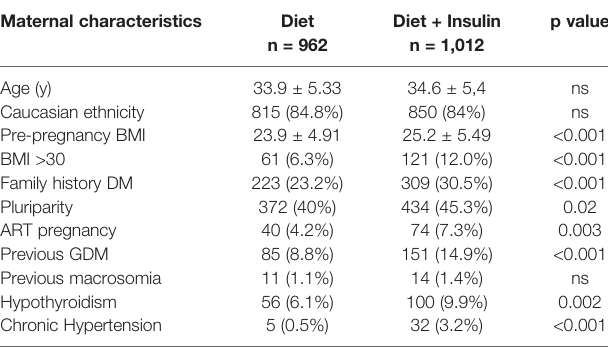
TABLE 1 | Maternal characteristics, including anthropometric data, family and clinical history, of women with GDM treated with only diet and those requiring also